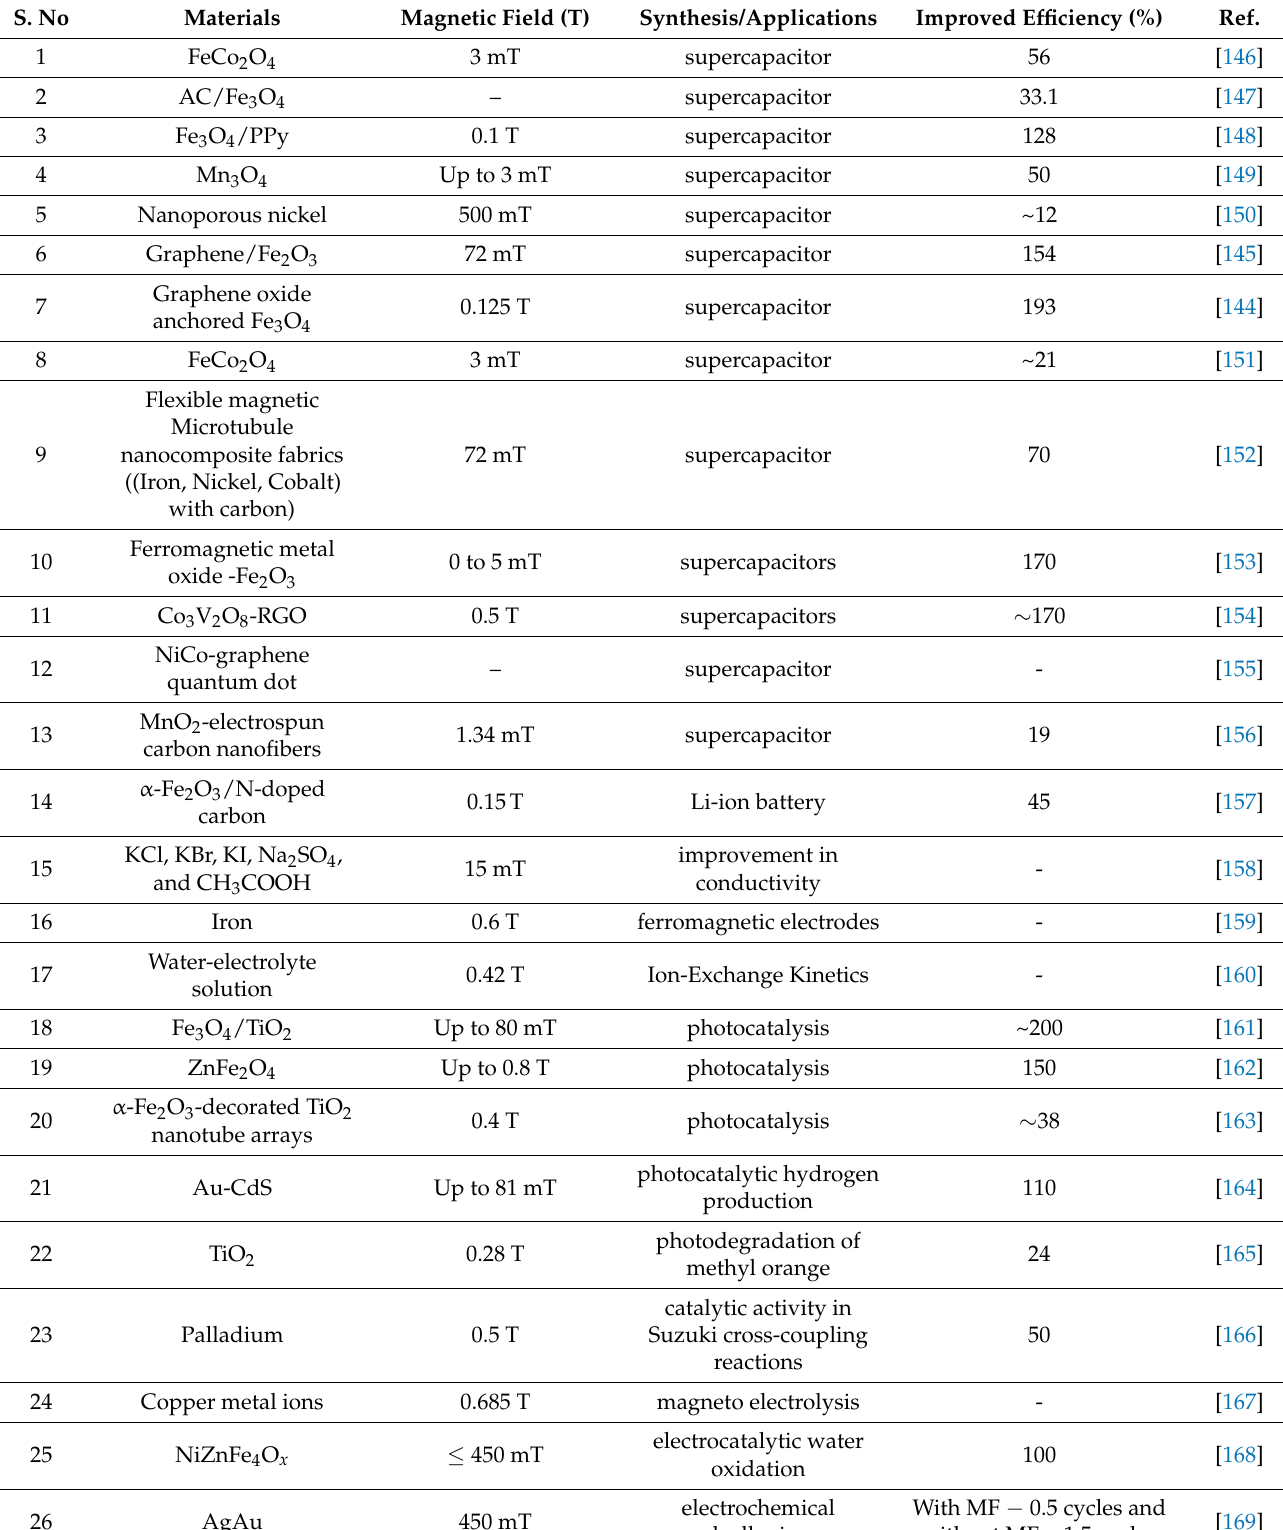
Table 3. Utilization of external magnetic field for the synthesis and